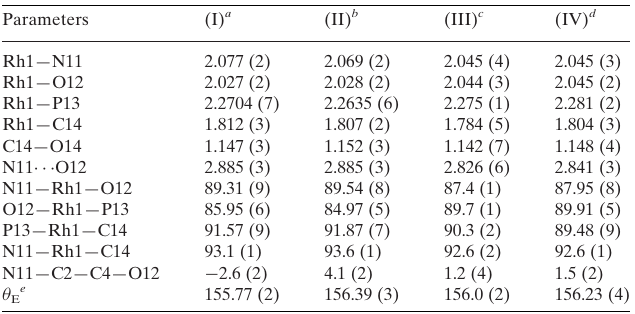
Comparative geometrical parameters (A˚ , (cid:3) ) for similar [Rh( N , O -bid)- (CO)(PPh 3 )]